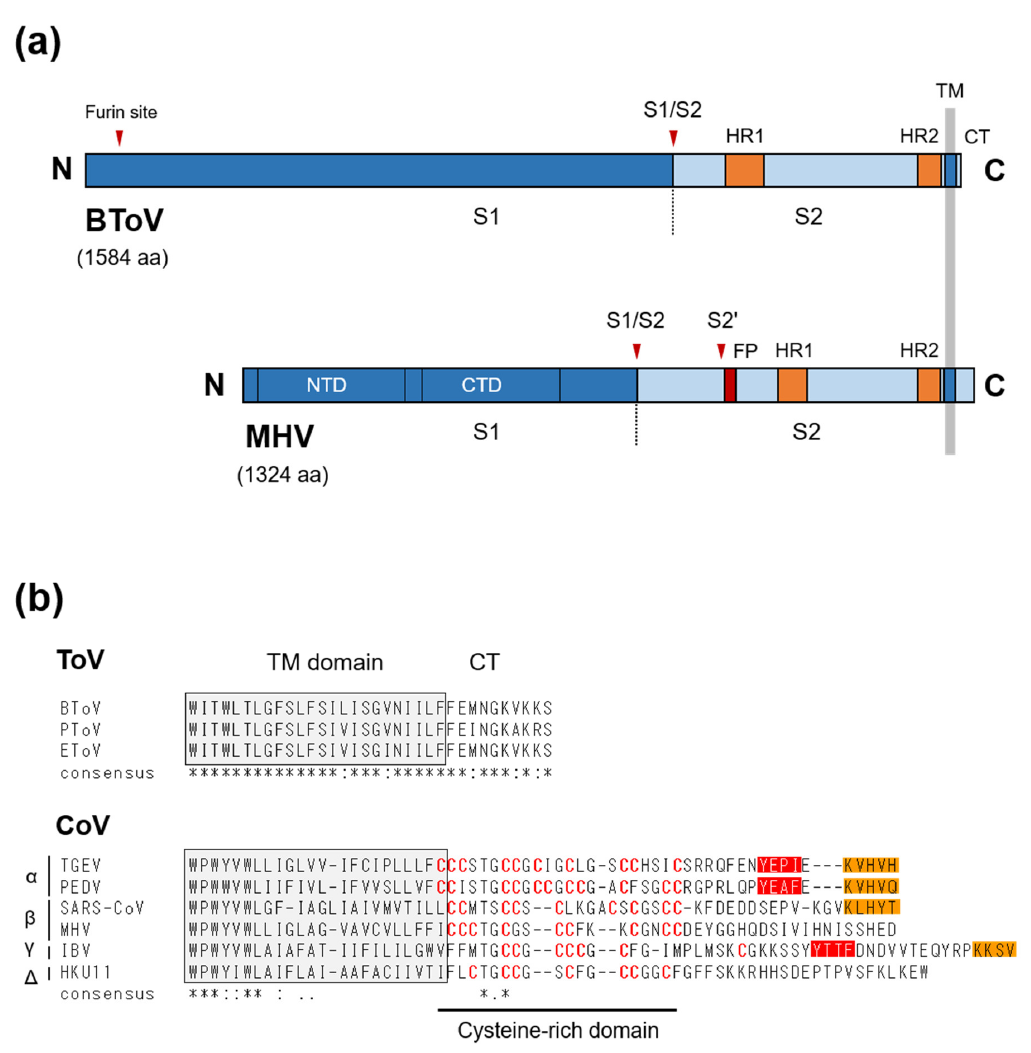
Figure 5. ( a ) Schematic diagrams of the S proteins of ToV and CoV. BToV contains two furin sites, an S1/S2 site and an additional site near the N-terminal end, whereas MHV (CoV) has two well-defined protease cleavage sites, S1/S2 and S2′ (arrowheads). The S protein consists of two subunits, the S1 receptor-binding subunit and the S2 fusion subunit. NTD: N- terminal domain of S1, CTD: C-terminal domain of S1, S1/S2, and S2′ cleavage sites, furin-site: additional furin cleavage site, FP: putative fusion peptide, HR1: heptad repeat 1, HR2: heptad repeat 2, TM: transmembrane domain, CT: cytoplas- mic tail. ( b ) C-terminal ends of three ToV and six CoV S proteins. Amino acid sequence alignment was performed using the ClustalW program. Shaded box indicates the deduced TM domain. Cysteine residues in the cysteine-rich domain of CoVs are indicated in red. Orange and red boxes indicate potential ER retrieval signals (KxHxx- or KKxx-motif) and tyro- sine-dependent localisation signals/internalisation signals (Yxx Ɵ motif, where Ɵ can be F, I, L, M, or V), respectively. Host proteases play very important roles in the fusion activity of CoV S protein [153]. CoVs can use two distinct pathways, via fusion activity either directly at or near the cell surface or through the endosomal compartment, depending on the localisation of host proteases [157,158]. CoV S protein contains two distinct proteolytic cleavage sites, S1/S2 and S2’ located upstream of the putative fusion peptide, both of which are recognised by a variety of host proteases to activate S protein [153]. Although the proteolytic S-activation mechanisms vary among CoV species, that of SARS-CoV has been fully characterised. Without extracellular proteases, SARS-CoV was internalised through the endosomal com- partment, and the S protein was activated by endosomal protease cathepsin L, leading to